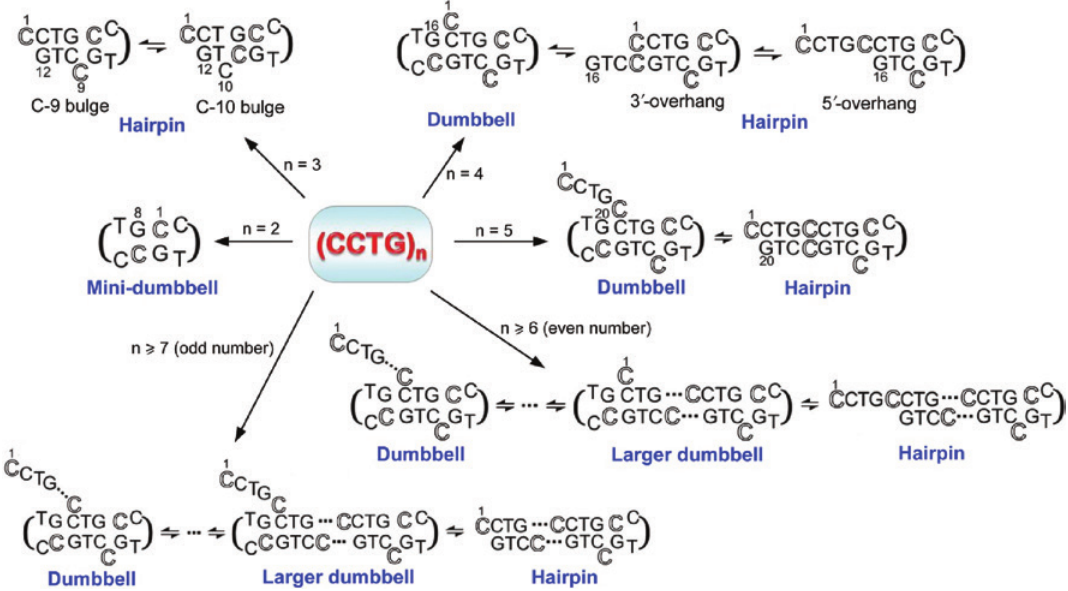
Figure 3: A summary of the diverse unusual structures formed by CCTG